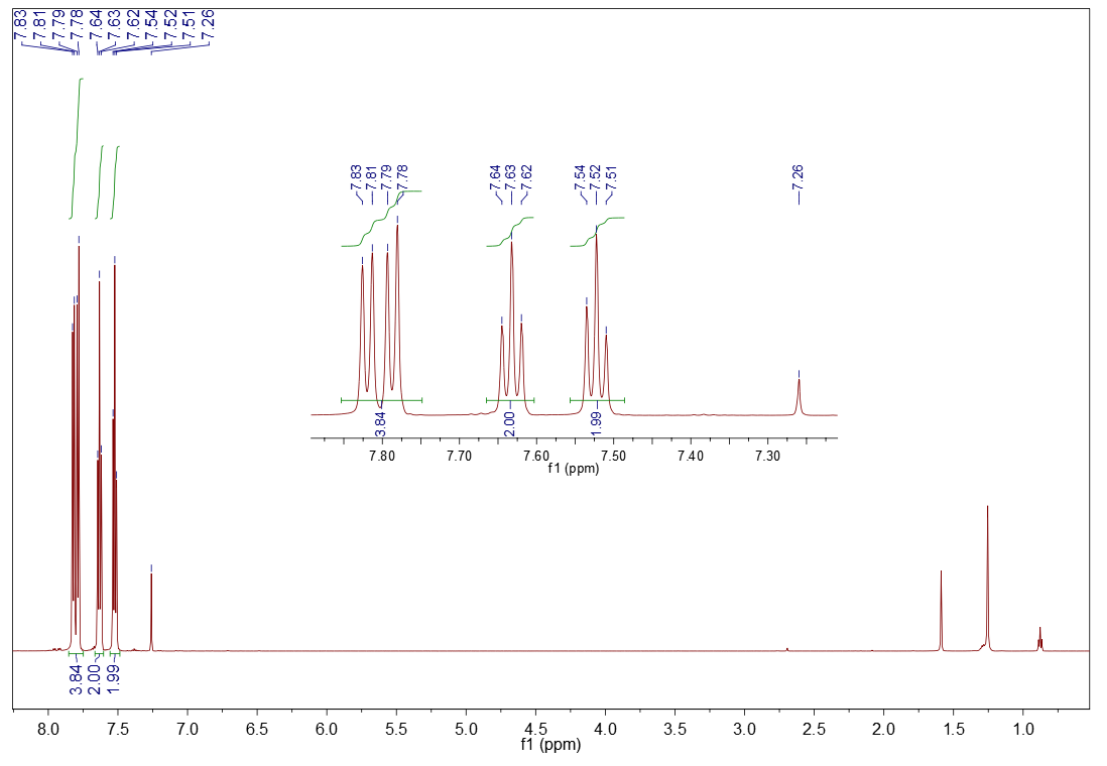
Figure 8. 1 H NMR spectrum of sediment precipitated from the surrogate LCO. Sample of 10 mg in 0.7 mL deuterated chloroform, 600 MHz.